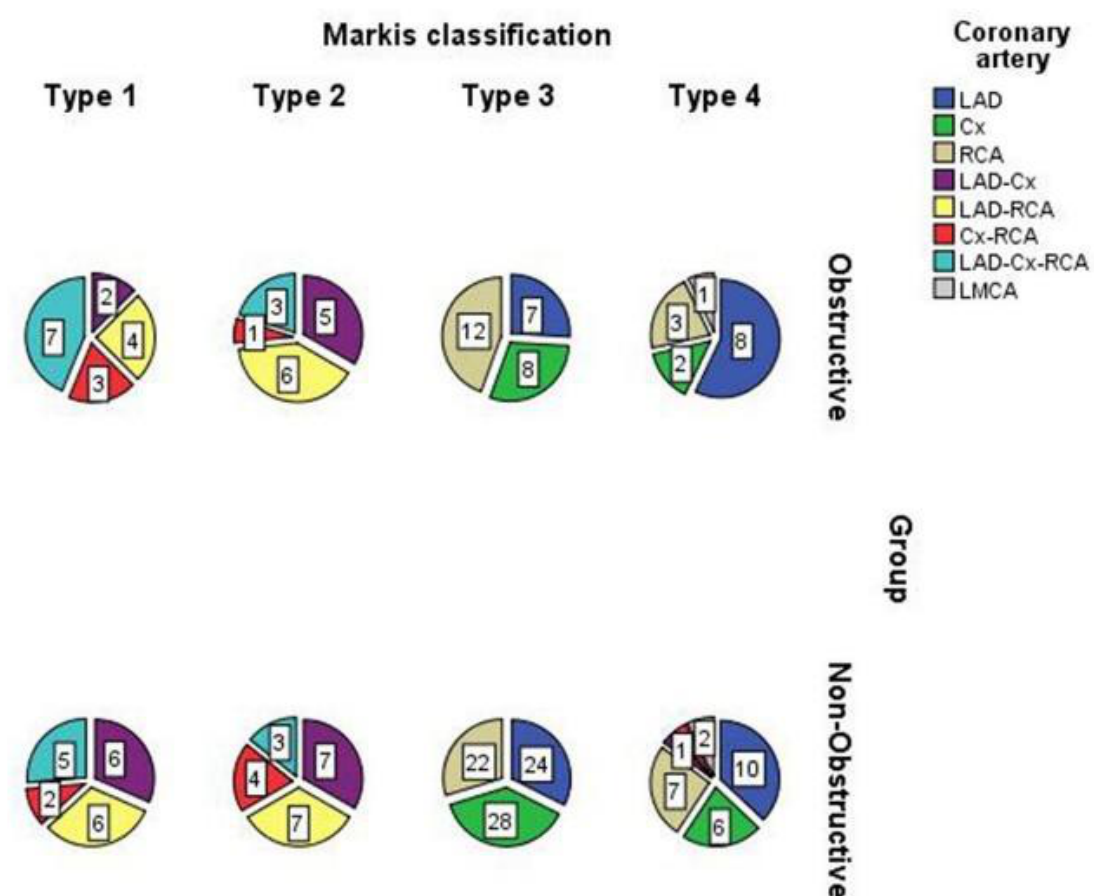
Figure 2: The distribution of the coronary arteries based on the Markis classification and the presence of obstruction.